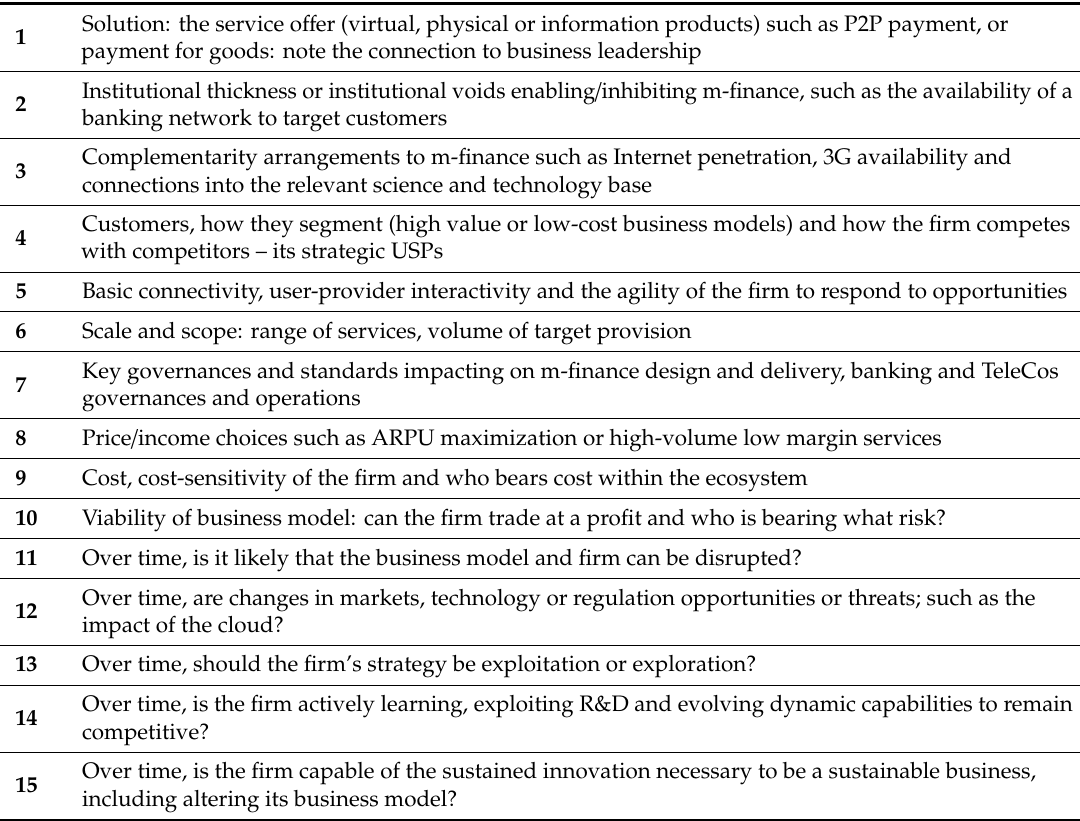
Table 1. Fifteen variables in analytical